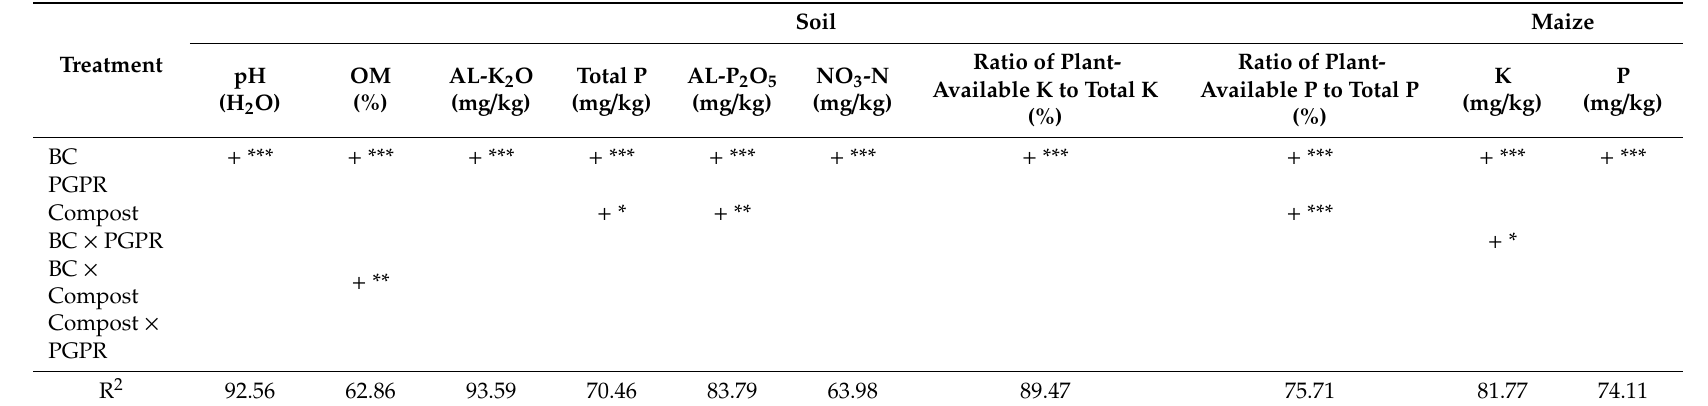
Table 6. Coe ffi cient of determination ( R 2 ) and p values for parameters with R 2 values greater than 60% in the combined treatments.